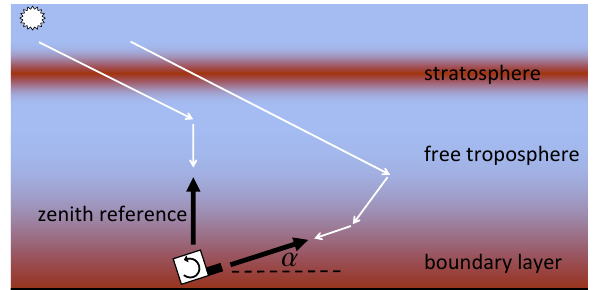
Fig.1. IllustrationofMAX-DOASobservation. TheMiniMAX-DOASinstrumentofthisstudycanrotateonly Fig. 1. Illustration of MAX-DOAS observation. The Mini MAX- inoneverticalplane,i.e.ithasafixedazimuth. Theviewingdirectionisreferredtoastheelevation,whichisthe DOAS instrument of this study can rotate only in one vertical plane, angle( α )withthehorizontal. ForboththeDOASmethodandrelativeintensityobservations,anobservationat i.e. it has a fixed azimuth. The viewing direction is referred to as the elevation α isalwayscombinedwithazenithobservation( α = 90 ◦ ). Twoexamplesofphotonpathsareshown elevation, which is the angle ( α ) with the horizontal. For both the in white. MAX-DOAS observations are relatively insensitive to the trace gases in the stratosphere, as long as DOAS method and relative intensity observations, an observation at thezenithandnon-zenithobservationsaretakenwithinatimeframewherethesolarzenithanglechangesonly elevation α is always combined with a zenith observation ( α = 90 ◦ ). little: the sensitivity of the MAX-DOAS observation to NO 2 in a particular horizontal layer is proportional to Two examples of photon paths are shown in white. MAX-DOAS thedifferencein(detected)photonpathlengththroughthatlayer,betweentheobservationspointedatthezenith and at elevation α . observations are relatively insensitive to the trace gases in the strato- sphere, as long as the zenith and non-zenith observations are taken within a time frame where the solar zenith angle changes only little: the sensitivity of the MAX-DOAS observation to NO 2 in a particu- lar horizontal layer is proportional to the difference in (detected) photon path length through that layer, between the observations pointed at the zenith and at elevation α